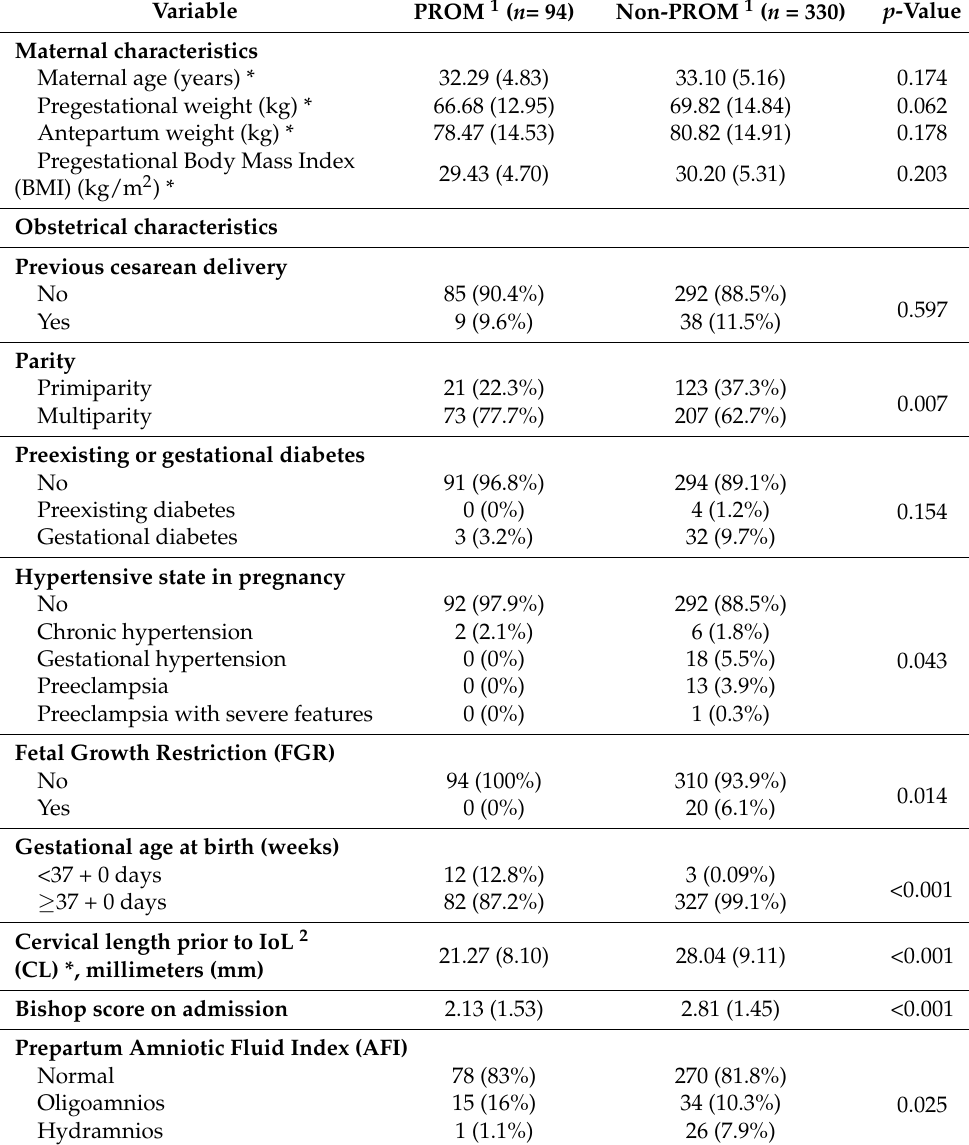
Table 1. Demographic characteristics of the study population according to PROM